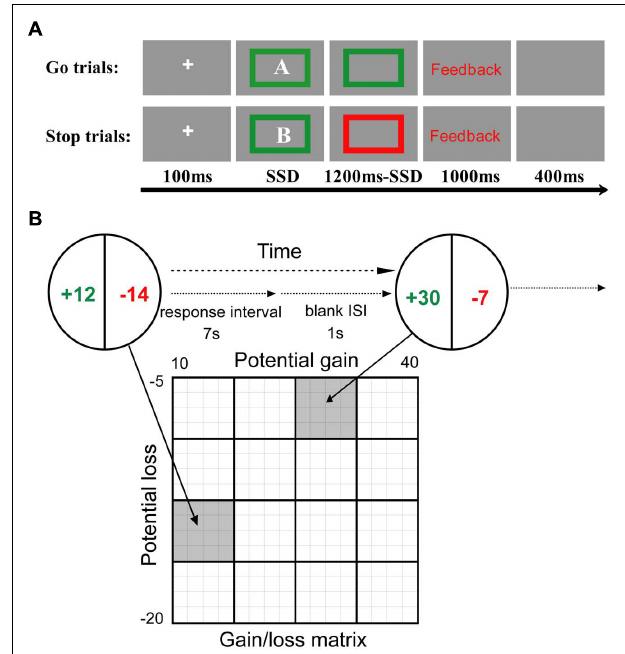
FIGURE 1 | Behavioral tasks. (A) The stop signal task. In this task, the participants were asked to discriminate between the letters “A” and “B.” In 33.3% of the trials, the “stop” signal, a red box surrounding the letter (opposed to the box remaining green in the “go” trials), was presented at variable delays after the letter was displayed. The total duration of the onscreen display of the letter and color box was 1200 ms. The time interval between the go and stop signals (the stop signal delay, SSD), began at 300 ms and was updated with a step of 50 ms per trial using a staircase procedure. (B) The mixed gambles paradigm. The participants were asked to accept or reject mixed gambles offering equal (50%) chances of gaining or losing different amounts of money. All combinations of gains and losses were presented. ISI, interstimulus